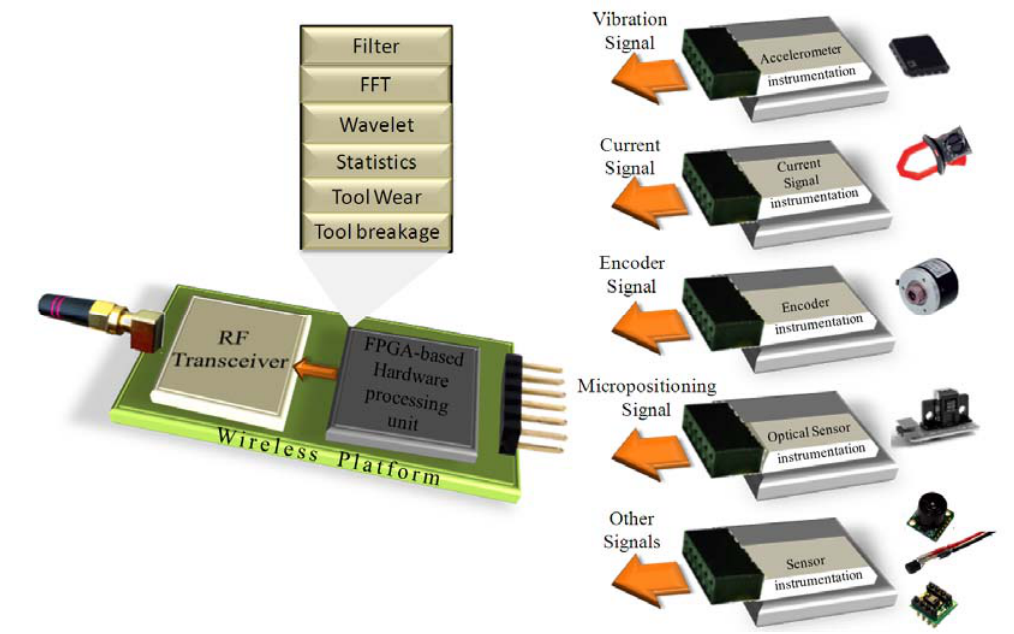
Figure 4. Block diagram of the wireless platform.